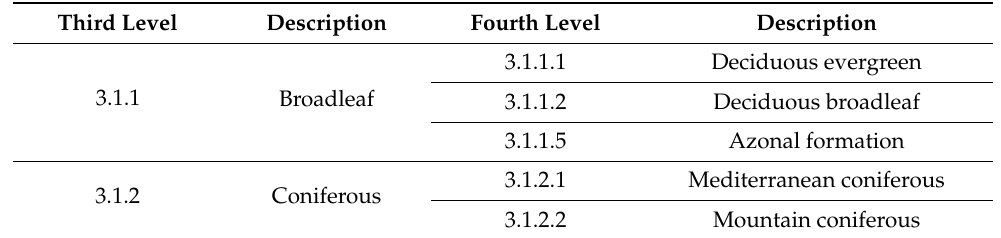
Table 3. Nomenclature system adopted in this study.